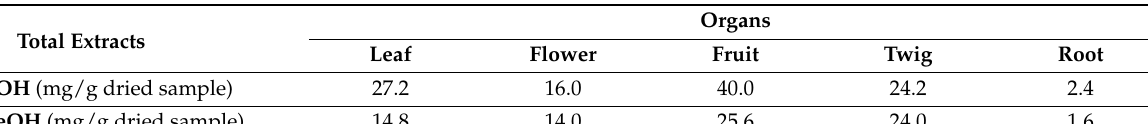
Table 1. Total amounts and antioxidant capacities (DPPH • and ABTS • + ) of organs (leaf, flower, fruit, twig, and root)